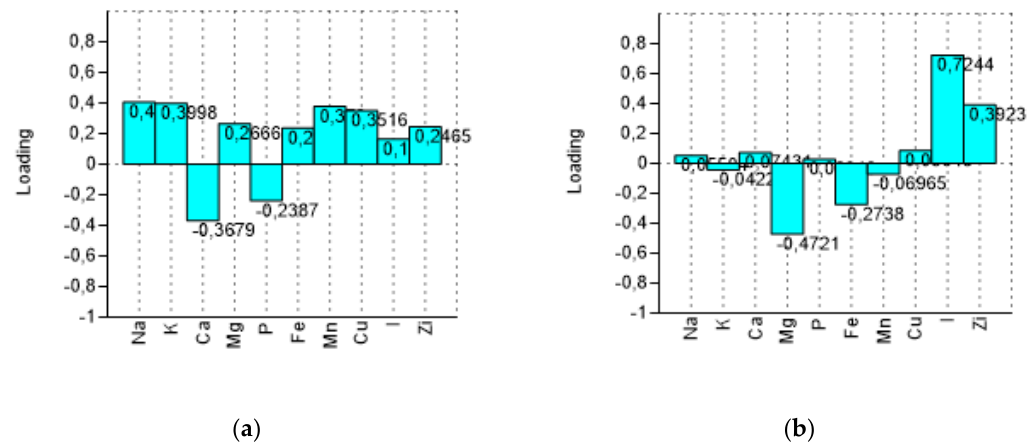
Figure 4. Loadings of variables (minerals) on the first two components (PC1 and PC2). ( a ) loading plot on PC1 and ( b ) loading plot on PC2.